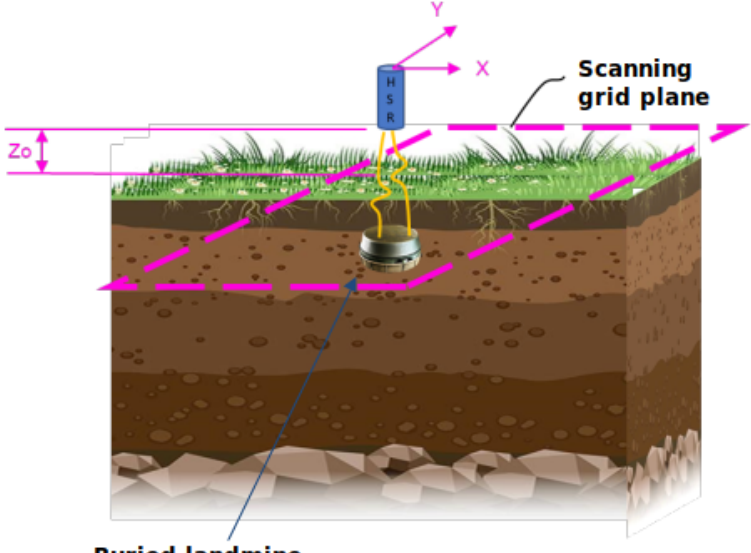
Figure 4. Illustration of the geometry of holographic acquisition. In blue the holographic RADAR antenna that is moved by the mechanical scanning frame (not illustrated) on the scanning plane (dashed pink rectagle) on fixed positions (a grid of 5 mm